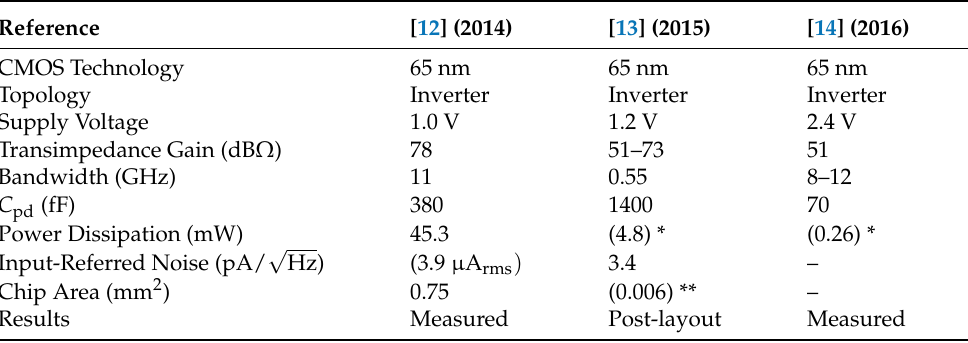
Table 2. Performance summary and comparison with other TIA